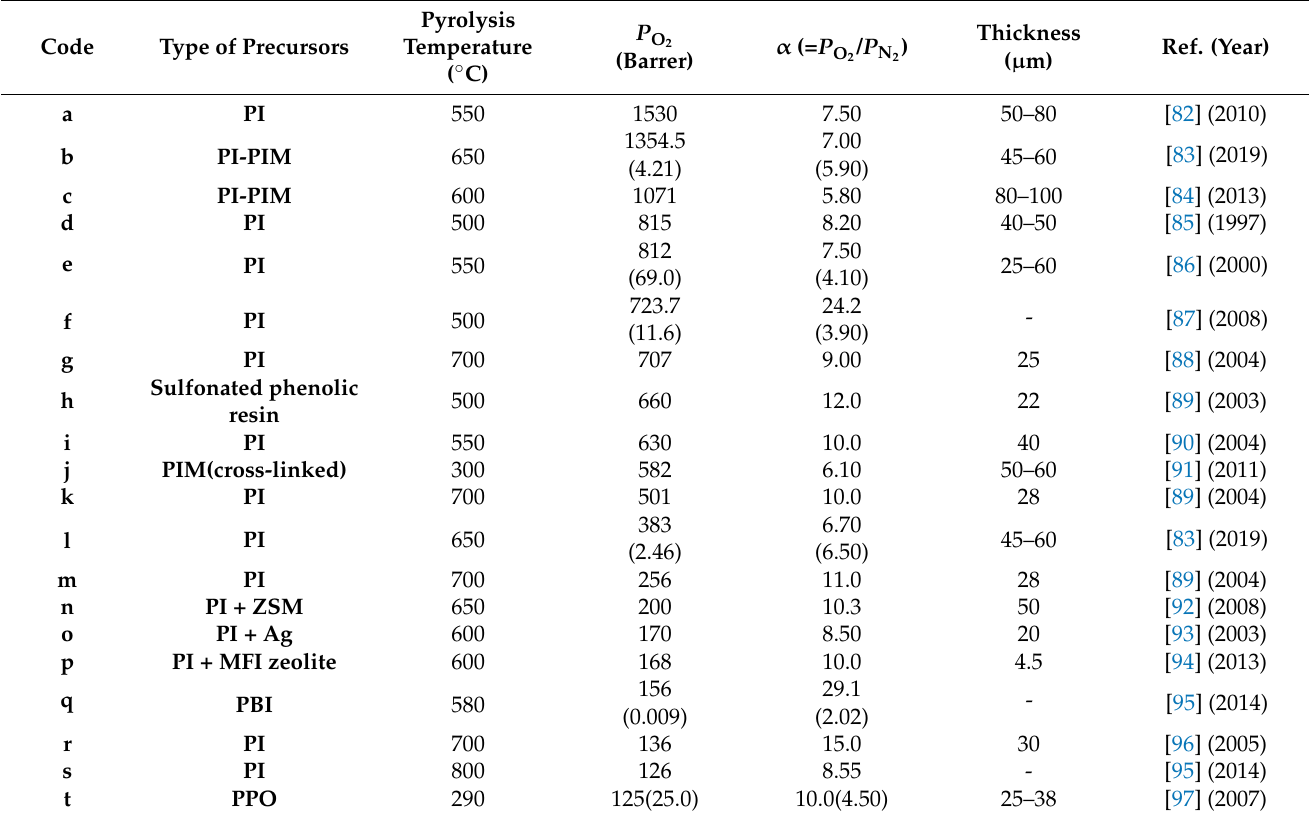
Figure 10. Plots of oxygen permselectivity through carbon molecular sieve membranes (CMSM), showing the highest α at each P O reported in the literature in 2020. For the data and categorization of the precursor polymers of the plots, see 2 Table 8, and for the chemical structures of the precursor polymers of the plots, see Chart 7. Table 8. Categorization and detailed data for CMSMs in Figure 10 (CMSMs in